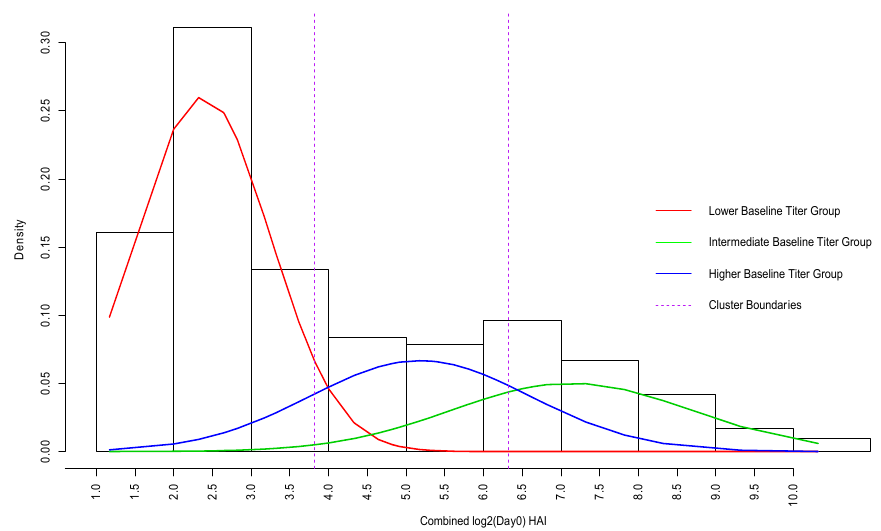
Figure 4. Gaussian Mixture Model (GMM) estimate of densities of day-0 HAI (log 2 ) for combined data. The red density represents the lower baseline titer group, the green density is the intermediate baseline group, and the blue density represents the higher baseline titer group. The vertical dashed lines indicate the different group boundaries based on the maximum posterior probability. We used these boundaries to identify the cutoff points for creating the low, medium, and high day-0 titer groups for gene − based modeling.